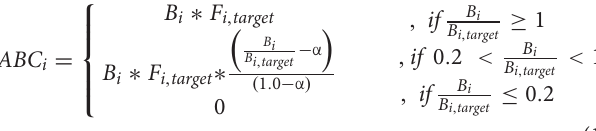
Sebastes zacentrus [Sharpchin rockfish], S. ciliatus [Dusky rockfish], Sebatolobus alascanus [Shortspine thornyhead], other Sebastes